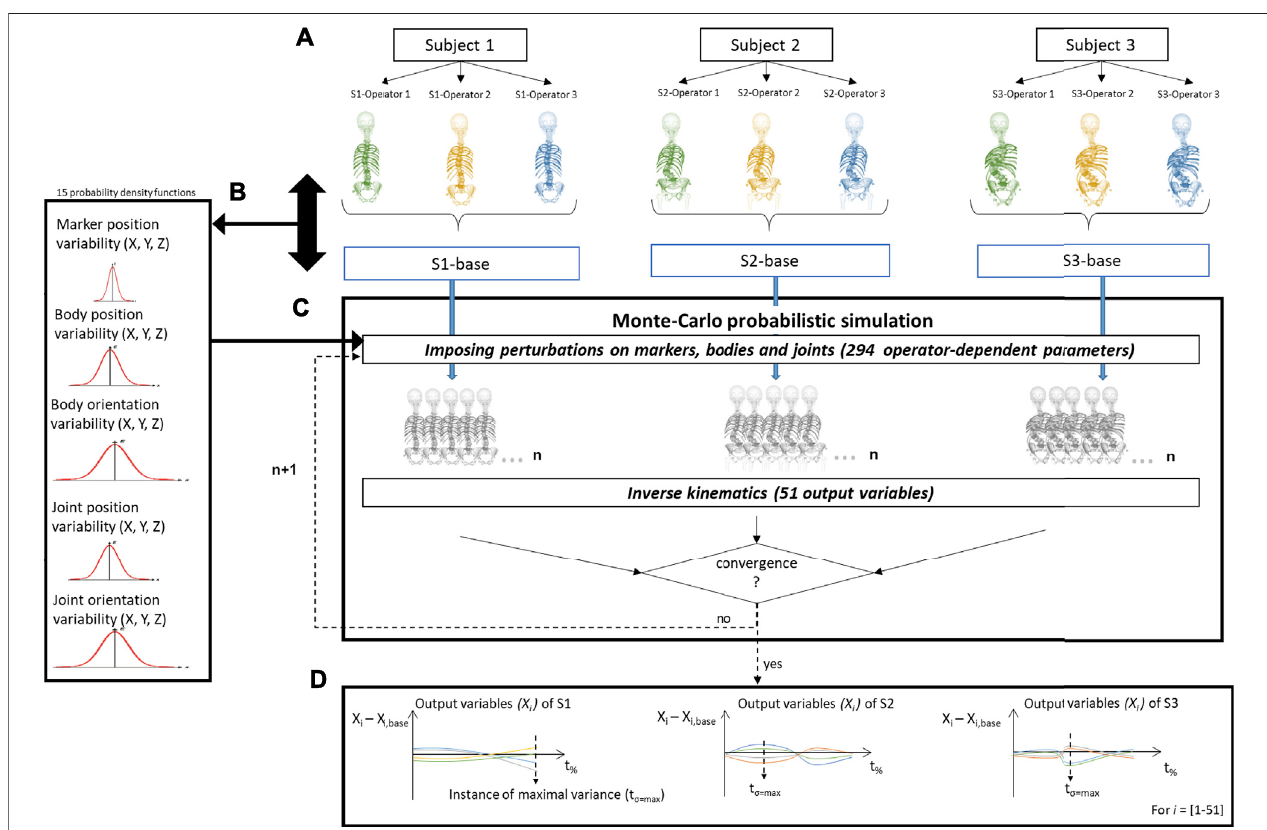
FIGURE 3 | Schematic representation of the determination of the inter-operator reliability of subject-speci fi c modeling. (A) For each subject (S), a subject-speci fi c modelwascreatedbyeachofthethreeoperators(O).Abaselinemodel(S-base)wasthencreatedforeverysubjectbyaveragingthesethreerespectivemodels. (B) The variability in the operator-dependent parameters was calculated in relation to the respective baseline models, pooled together for all vertebral levels and subjects, and separated by direction. (C) In the Monte-Carlo probabilistic simulation, variations on the baseline model were created by imposing statistically probable error combinations on the operator-dependent parameters and then used to perform inverse kinematic simulations until the convergence criterion on the output variables (i.e.,thejointangles)wasreached. (D)